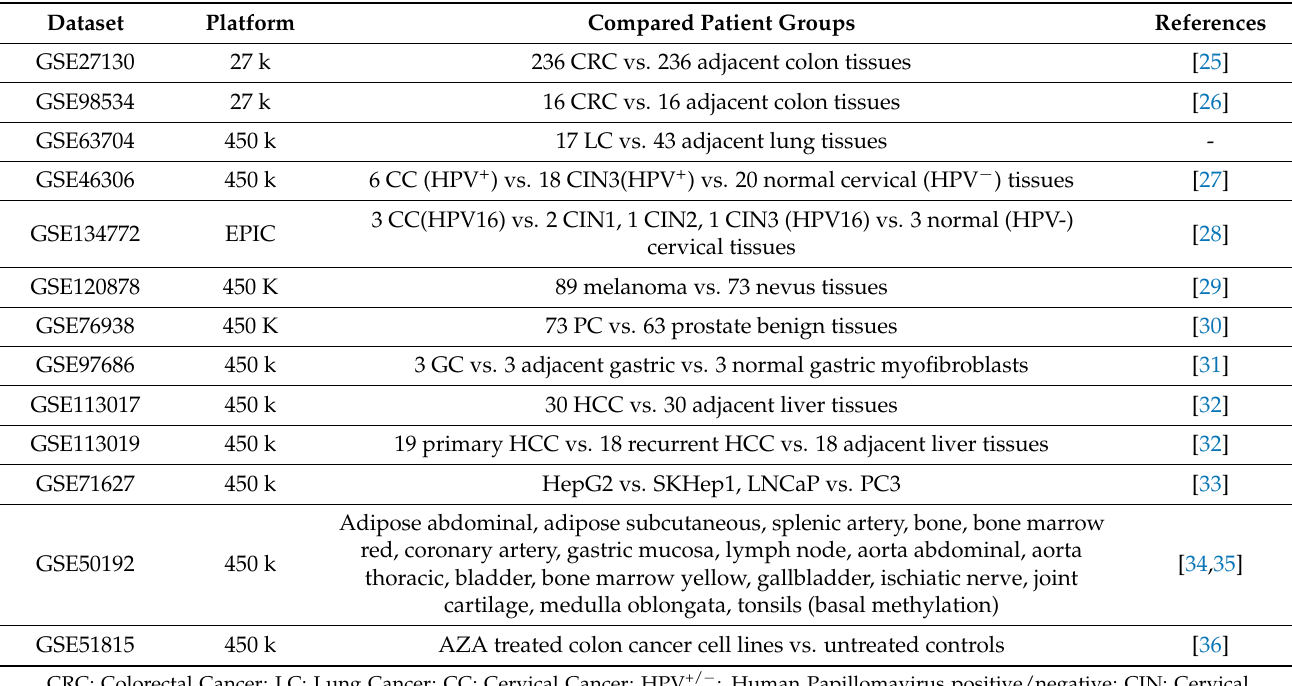
Table 1. Methylome datasets retrieved from GEO for the in silico analysis of ENPP2 methylation. Dataset Platform Compared Patient